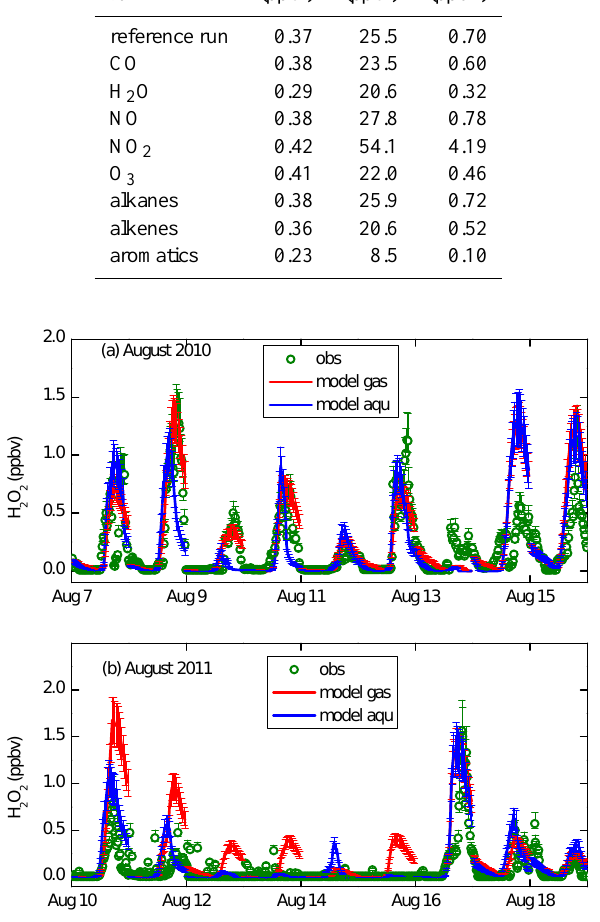
Fig. 7. Observed and modeled H 2 O 2 concentrations on 7–15 Au- gust 2010 and 10–18 August 2011. Green circles: observed H 2 O 2 ; red line: modeled H 2 O 2 with standard gas phase chemistry; blue line: modeled H 2 O 2 with the inclusion of aqueous phase chemistry. The error bar for observed data represents the uncertainty caused by instrument fluctuation and SO 2 interference; the error bar for mod- eling data represents the uncertainty (1 σ ) caused by the uncertainty of concentrations of the constrained